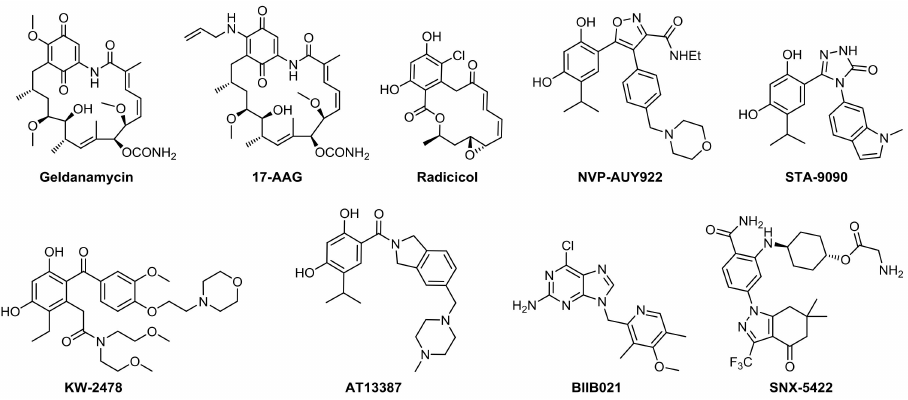
Figure 1. Representative Hsp90 inhibitors in clinical